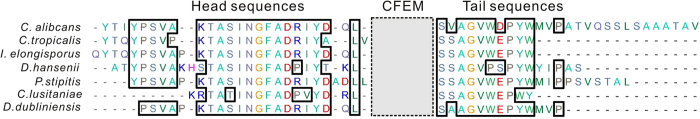
Conserved head and tail sequences of CFEM domains across different fungi.